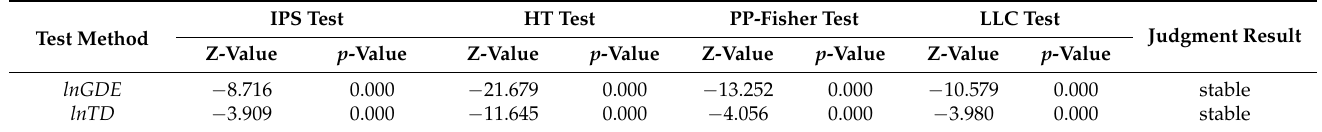
Table 3. Results of unit root test for TD and GDE.